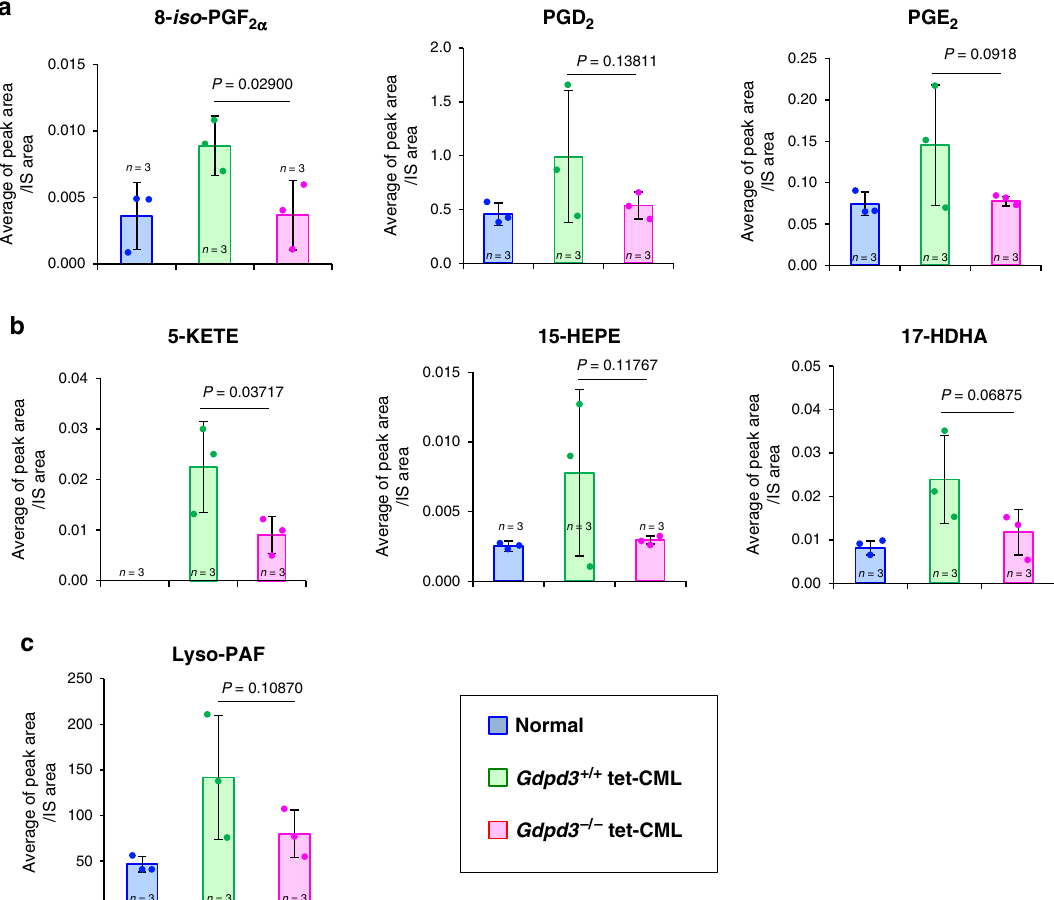
Fig. 4 Lysophospholipase D Gdpd3 is required for the production of lipid mediators in CML cells in vivo. Global lipidomics analyses (see “ Methods ” , Supplementary Method 2, 3) for the lipid mediators in BMMNCs (1 × 10 7 ) isolated from healthy 8-wk-old normal C57BL/6 mice (two males, four females), or Gdpd3 + / + tet-CML-affected mice ( fi ve females), or Gdpd3 − / − tet-CML-affected mice (one male, three females), at 5 weeks post-Dox withdrawal. Data are the mean average±s.d. of peak area normalised to IS (internal standard) area ( n = 3 biologically independent samples) ( P -value, unpaired one-sided Student ’ s t -test). a Prostanoids, b eicosanoids and docosanoid, and c Lyso-PAF were